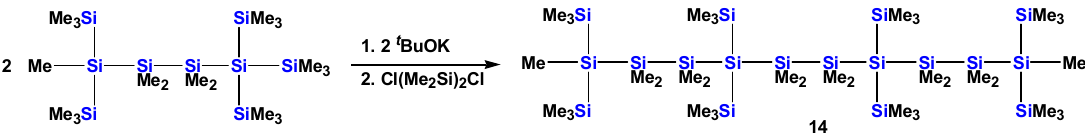
Scheme 4. Synthesis of a dodecasilane chain with two internal bis(trimethylsilyl)silylene units and bis(trimethylsilyl)methylsilyl end groups.